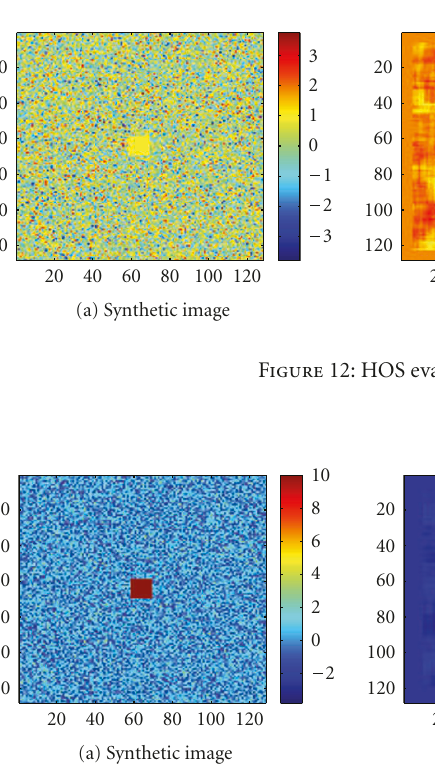
Figure 13: HOS evaluated on 21 × 21 windows (SNR = 20dB).